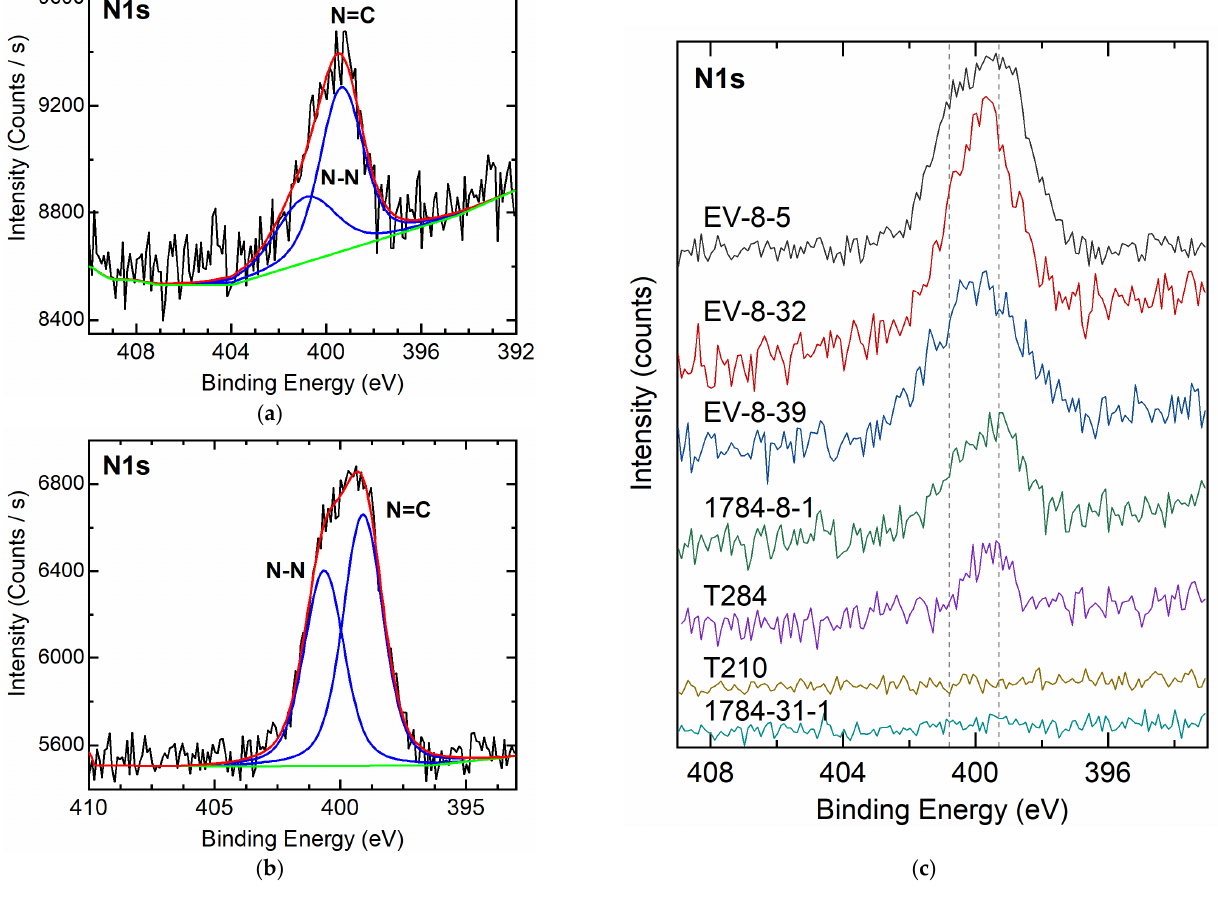
Figure 3. Typical XPS spectra of natural diamonds containing N–N and/or C–N bonding: ( a ) IaAB (1784-8-1); ( b ) IaB (EV-8-5); ( c ) comparison of all samples. Insets: white-light images of the diamonds under study. The low-intensity and noisy XPS signals result from the highly irregular shapes of the diamonds at the sub-millimeter scale, despite the rather long, 225-s acquisition (exposition) time. Furthermore, we explored the correlation between the XPS-based contents of nitrogen atoms in N–N and C–N bonds in at. % and FT-IR-based concentrations of the different nitrogen impurity defects in ppm (Figure 4). Accounting for the XPS detection limit of 0.1 at. %, these plots reasonably indicate the linear calibration relationship between XPS N–N intensity and Σ N (Figure 4a), similar to XPS C–N intensity and Σ N . The same is true for the other plots—XPS N–N intensity versus [A] (Figure 4b), and XPS C–N intensity versus [B1] (Figure 4c).